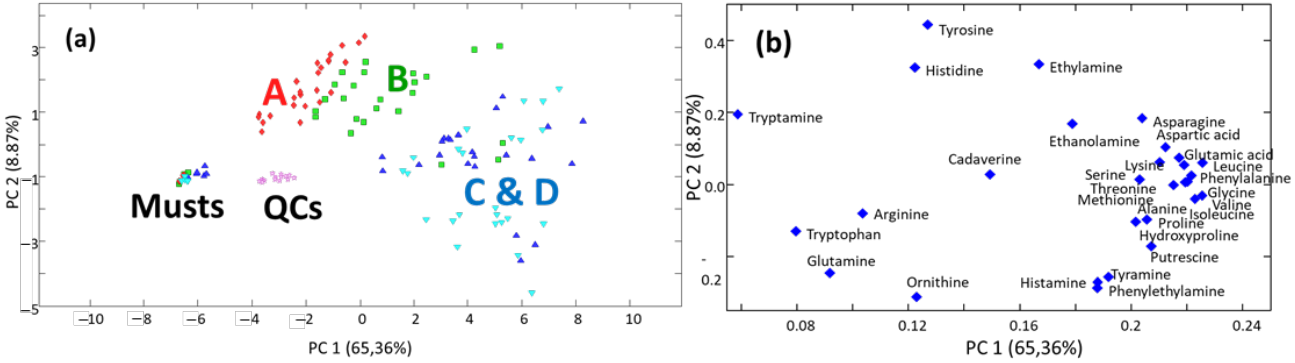
Figure 4. PCA results for the exploratory evaluation of musts, wines, and sparkling wines using a AA and BA profiles as the data. ( a ) Plot of scores of PC1 vs. PC1. ( b ) Plot of loadings of PC1 vs. PC2. Sample assignation: QCs, quality controls; A, A-type quality; B, B-type quality; C, C-type quality, D, D-type quality.